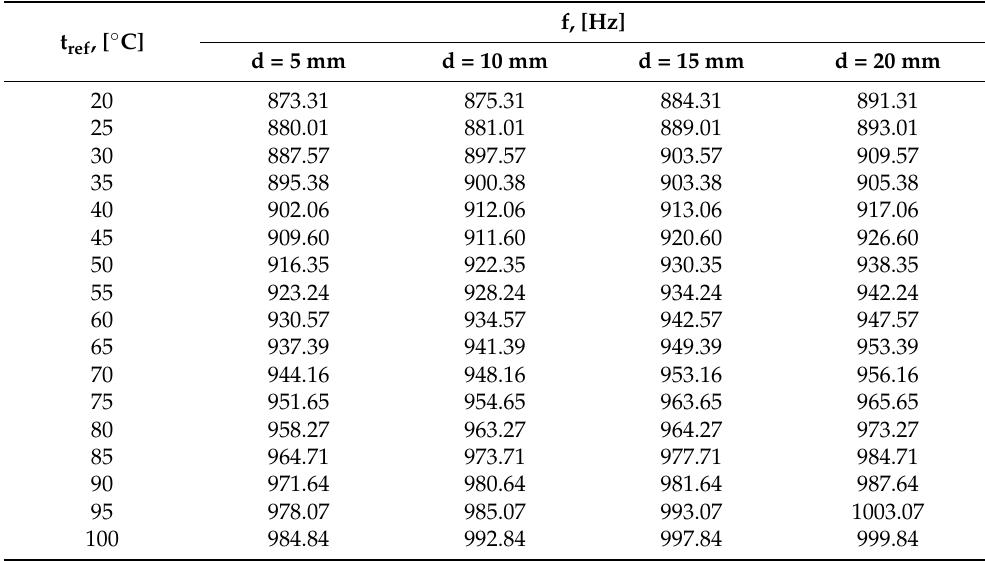
Table 1. Experimental results for temperature measurement using acoustic temperature